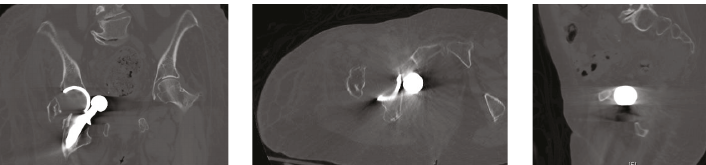
Figure 3: Coronal, axial, and sagittal computed tomography (CT) images showing femoral component dislocation through the right obturator canal and abutting the urinary